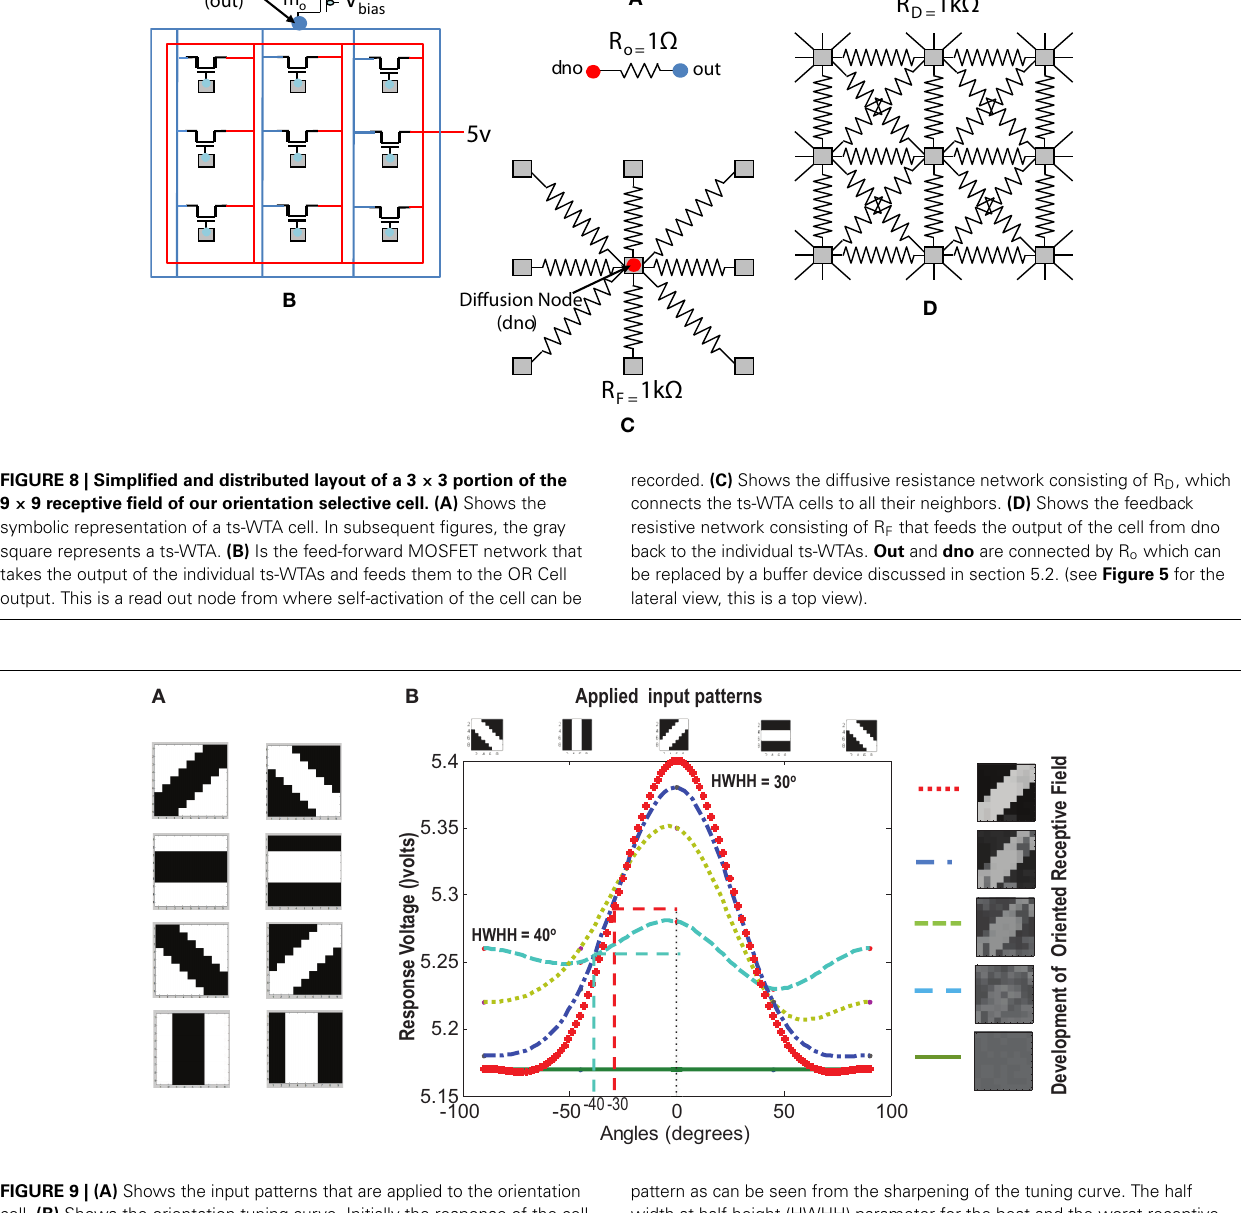
pattern as can be seen from the sharpening of the tuning curve. The half width at half height (HWHH) parameter for the best and the worst receptive field has been marked. The sharper the tuning, the lower is the value of